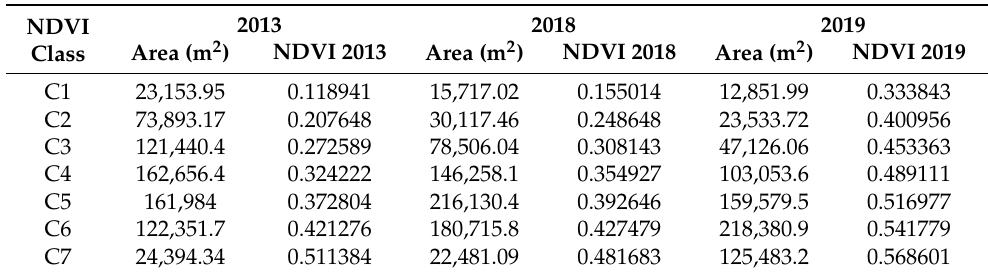
Table 7. Variation of land area of the pasture category, by NDVI classes, under the influence of pig sludge application, plot